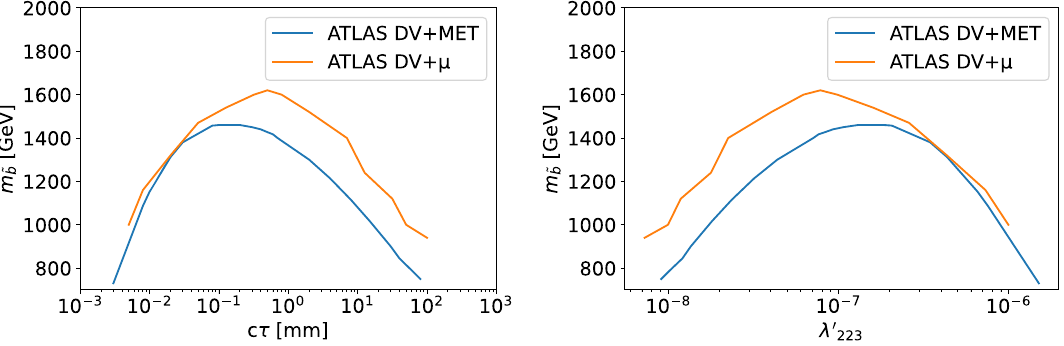
) plane of the LLP sbottoms 223